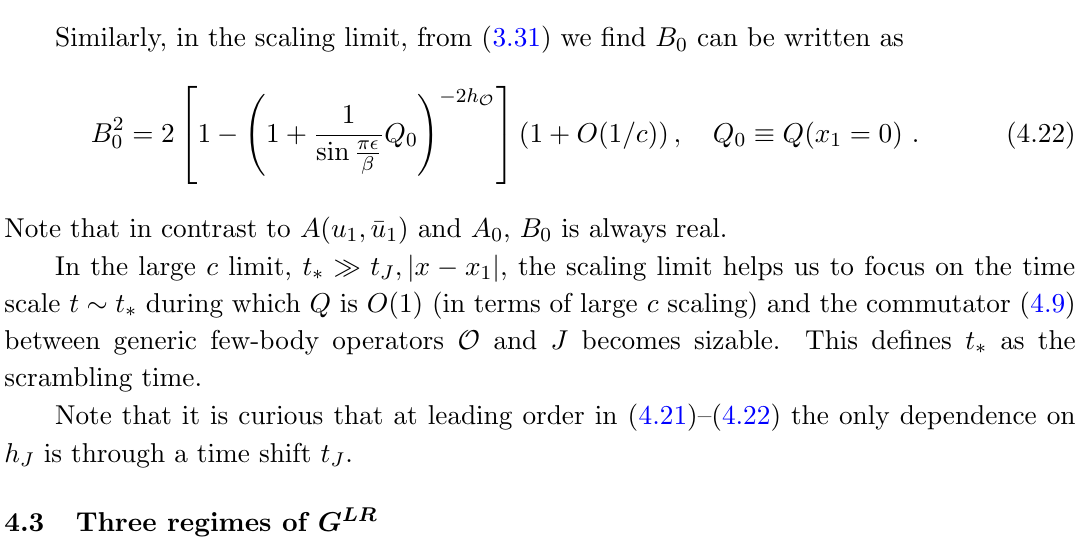
Figure 5 . (a) Plots of real (blue) and imaginary (yellow) part of A 0 for (cid:1) O = 8 = 9. The horizontal axis is y = 2 (cid:25) ( t (cid:0) j x j ). (b) Plots G LR for (4.6) for two values of g e(cid:11) : blue for g e(cid:11) = 2 and yellow (cid:12) for g e(cid:11) = 5. (c) Plots of G LR for k = 1 in (3.30) with (cid:15) = (cid:12)= 2 in (4.22). Blue is for g e(cid:11) = 2 and yellow is for g e(cid:11) =